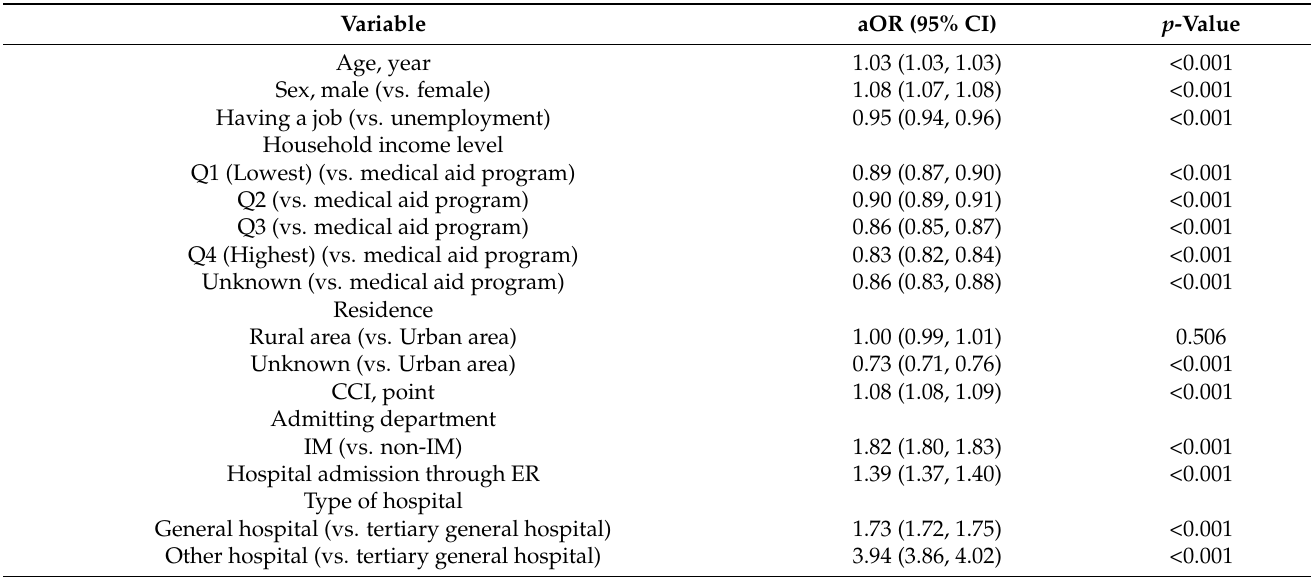
Table 3. Multivariable logistic regression model for in-hospital mortality among patients admitted to the ICU in South Korea from 2010 to